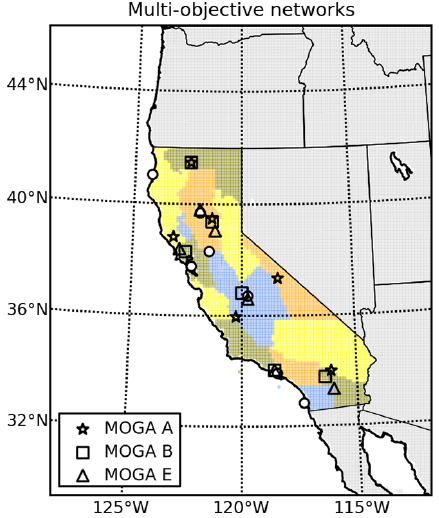
Figure 10. The figure shows the locations of observing stations in three networks that lie near the approximate Pareto frontier (see points A, B, and E in Fig. 9) using MOGA. Reference locations of the seven existing sites are also shown (white